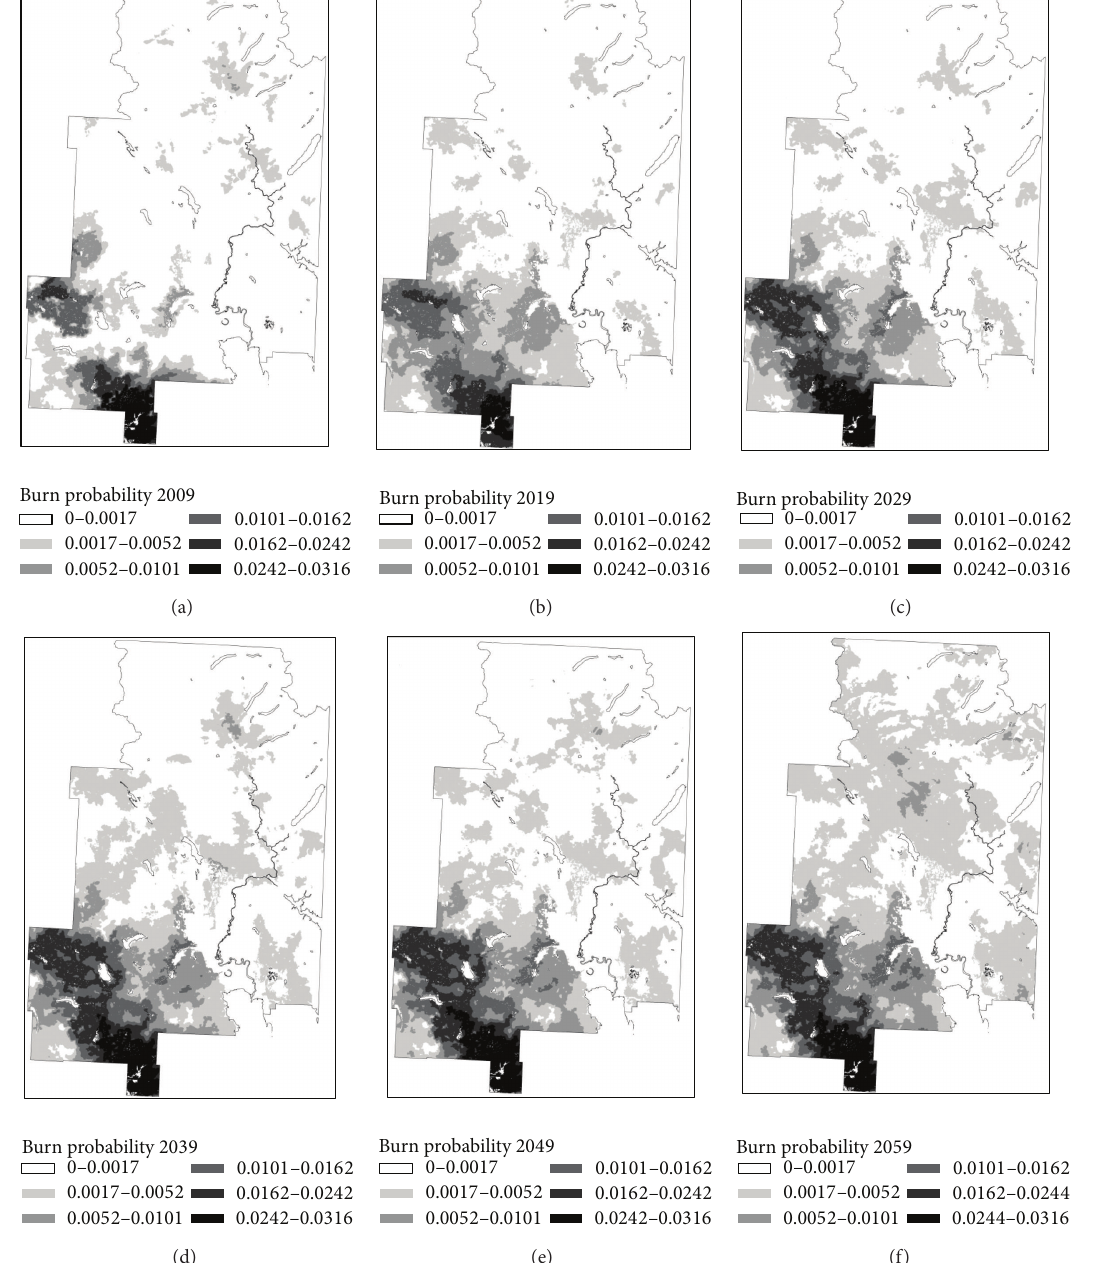
Figure 4: Subperiod simulated burn probabilities for developed parcels in Flathead